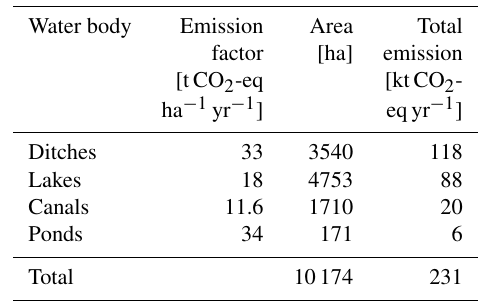
Table 1. Estimation of methane emissions in water bodies in the water management area of